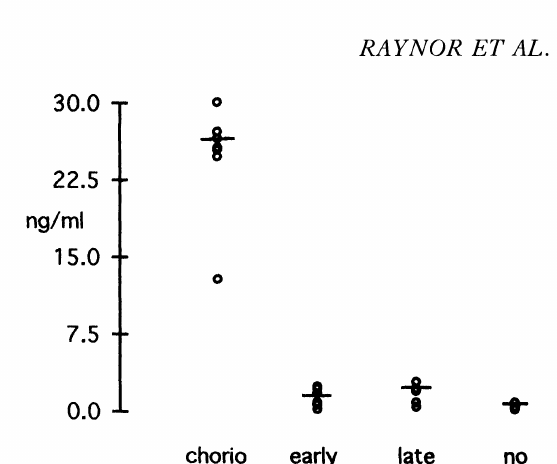
Fig. I. Amniotic-fluid G-CSF levels in chorioamnionitis, early labor, late labor, and prior to labor. Bars represent means. P < 0.00001) and prior to labor (0.49 +